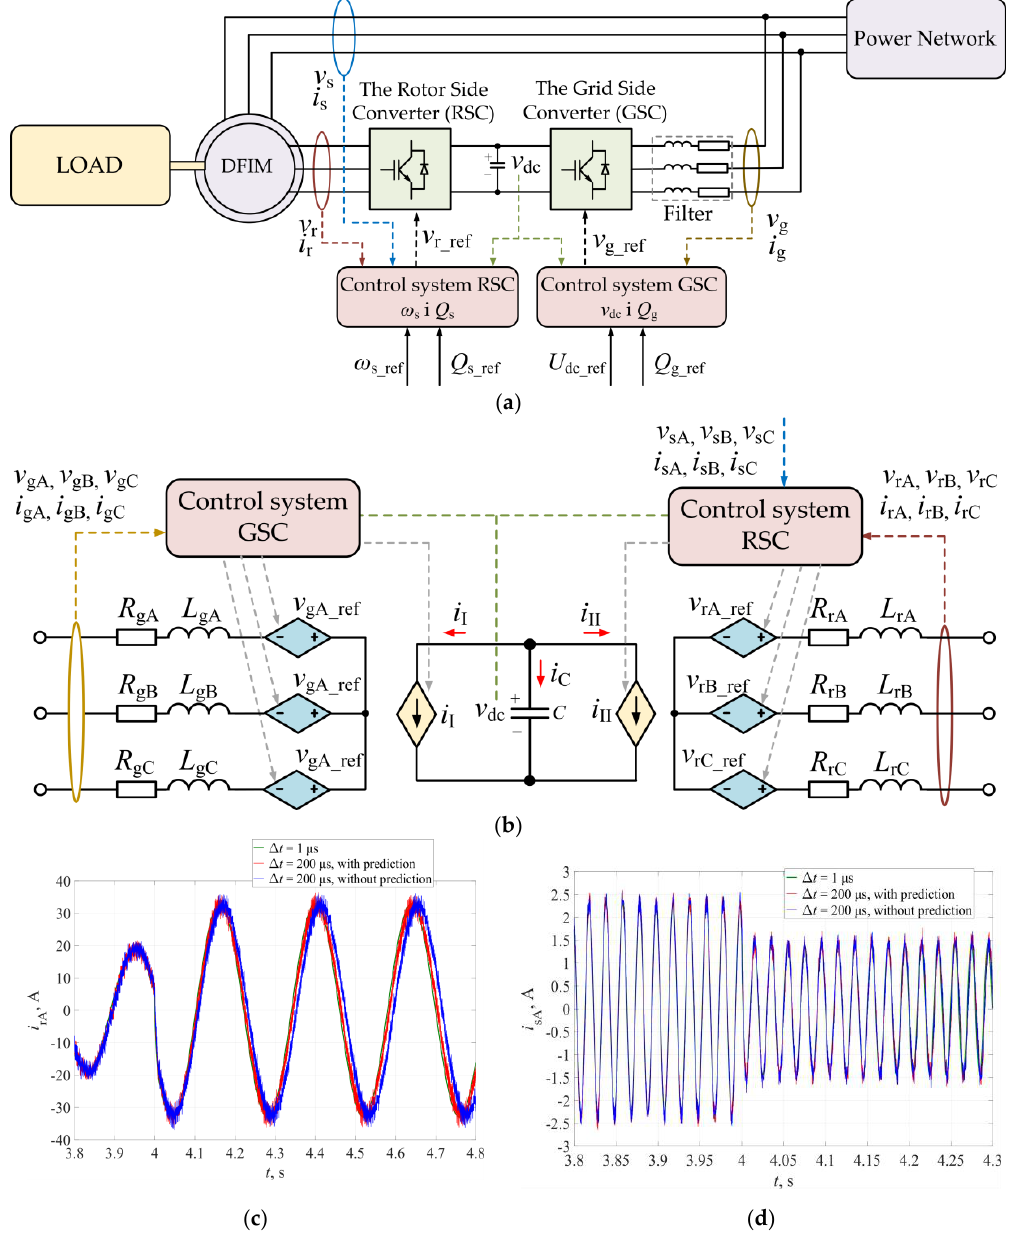
Figure 11. Schematic diagram of the modeled system ( a ), equivalent circuit diagram of power electronic converters ( b ) and waveforms of rotor current (phase A) ( c ) and stator current (phase A) ( d ) during the process of reducing the stator reactive power from 0.8 kvar to 0.